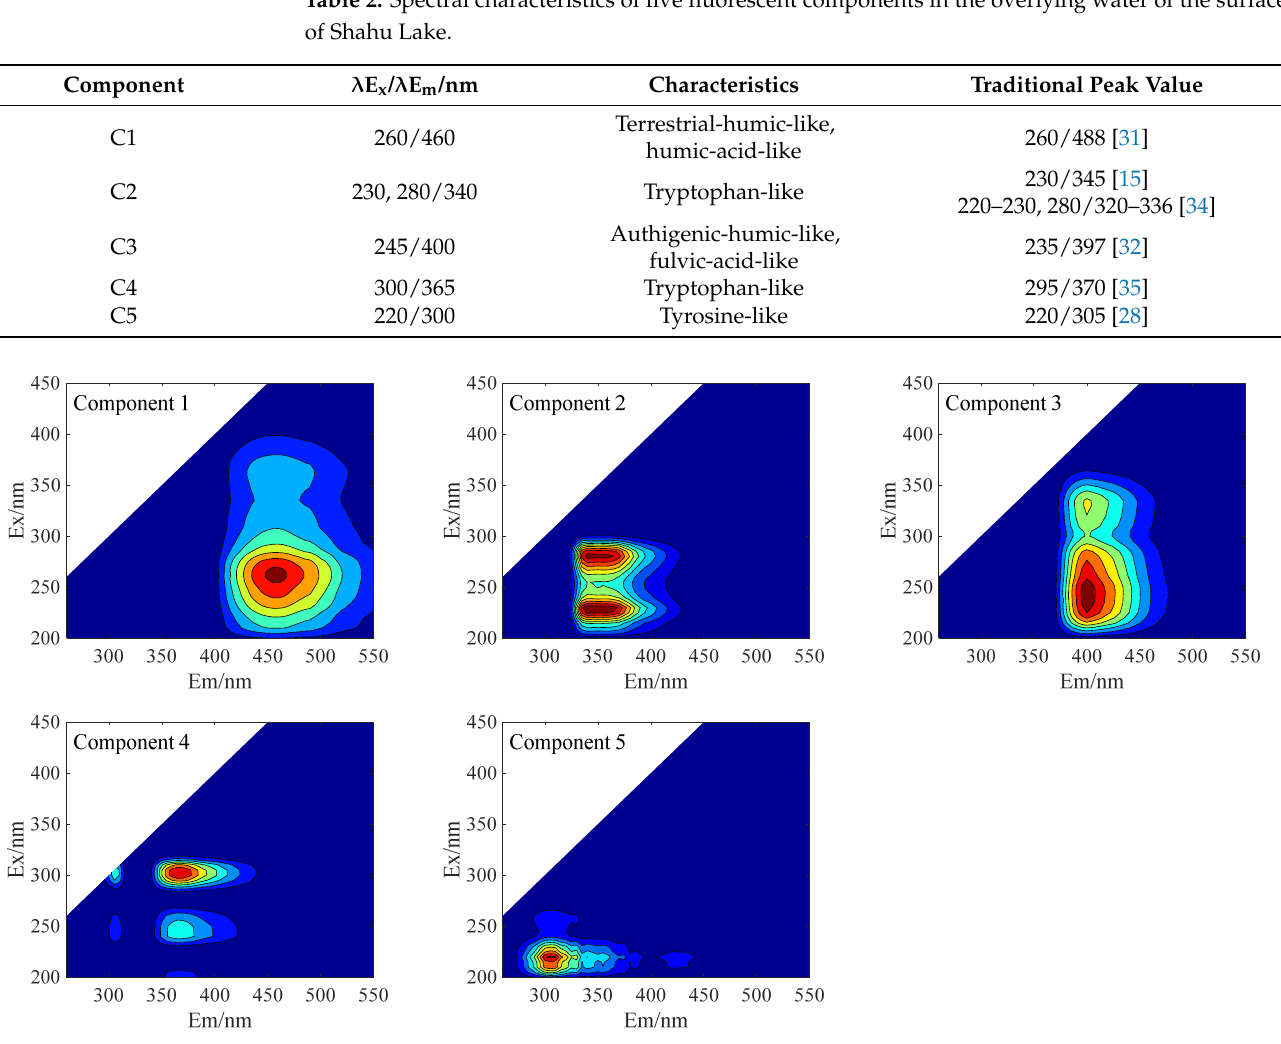
Figure 3. Five different components identified by the PARAFAC